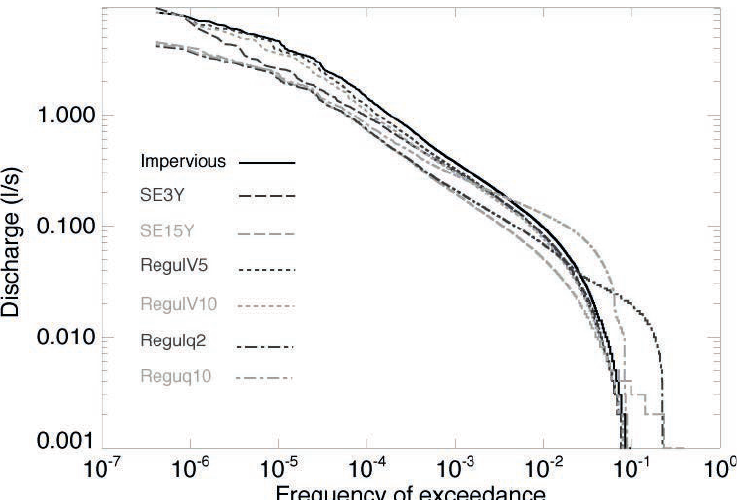
Fig. 1 Flow-frequency curves: comparison of discharge distribution for the impervious case, green-roof configurations (SE3Y and SE15Y), volume regulations (RegulV5 and RegulV10) and both discharge regulations (Regulq2 and